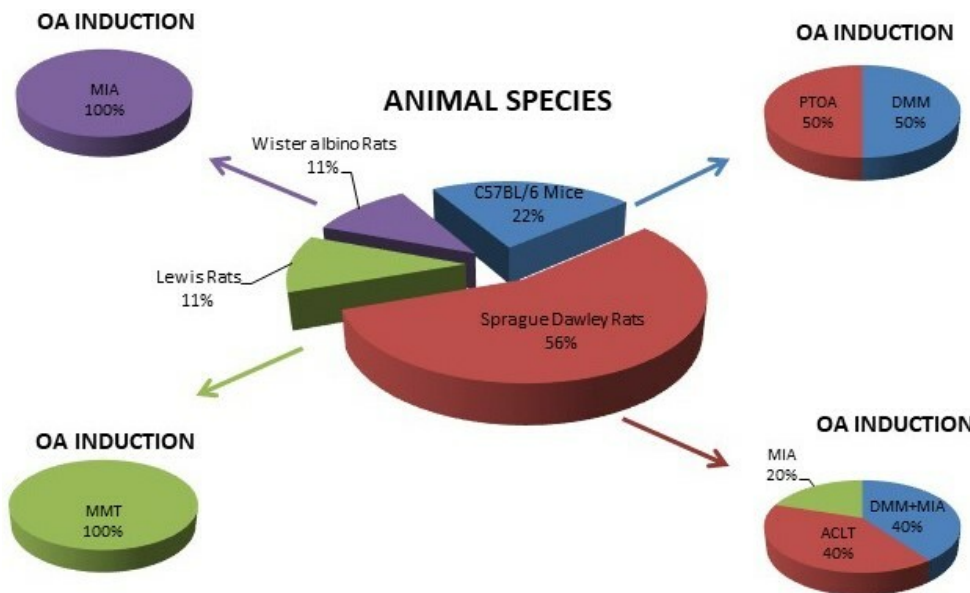
Figure 4. Diagrams of animal species and OA induction models adopted in the in vivo studies.